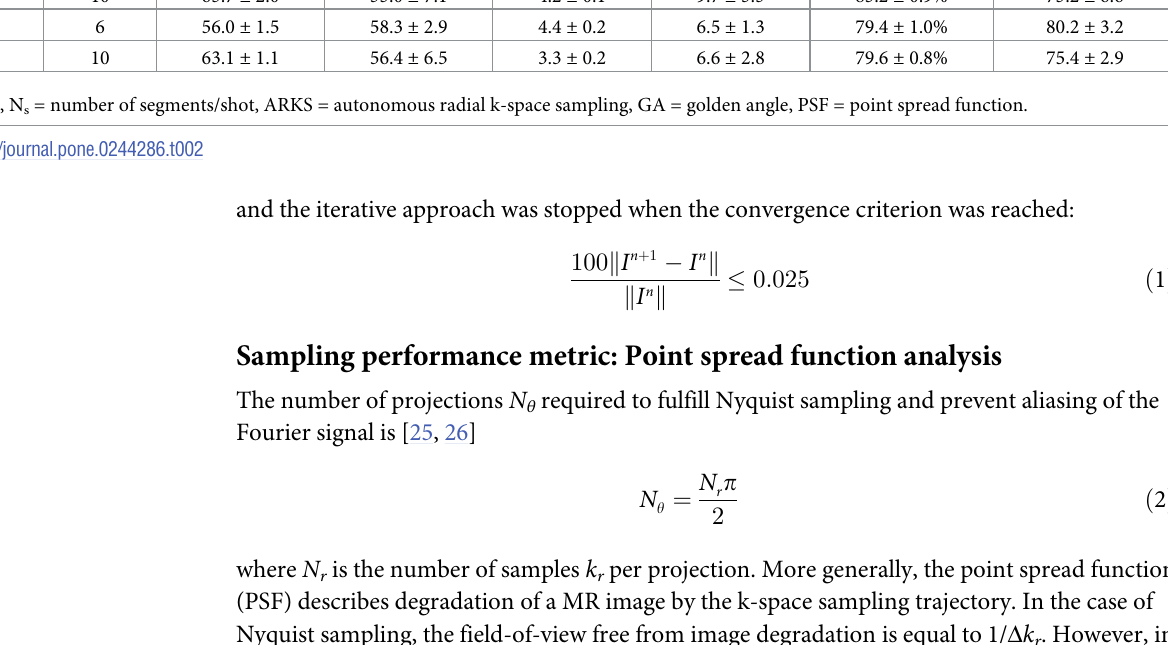
Sampling performance metric: Point spread function analysis